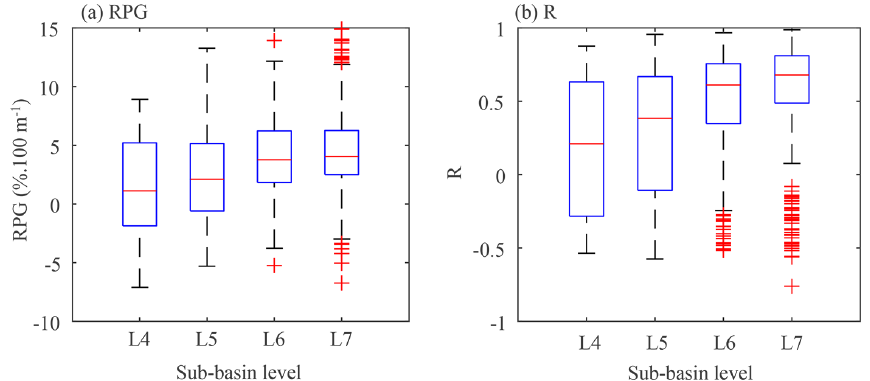
Figure 10. Comparison of (a) RPGs and (b) the correlations between precipitation and altitude calculated at different sub-basin levels. Each box represents the distribution of RPGs or correlations of all the sub-basins over the TP. The red line shows the median value of RPGs. The bottom and top edges of the box represent the 25th and 75th percentiles, respectively. The whiskers represent the extreme value. The red sign “ + ” shows the RPGs beyond the extreme